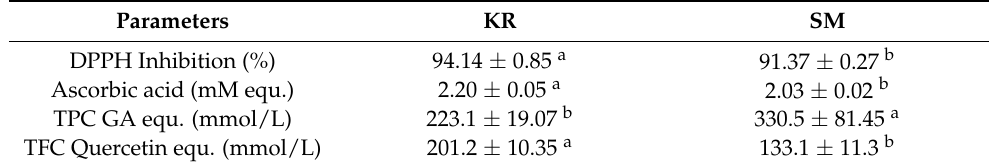
Table 5. Evaluation of antioxidant activity, total polyphenol, and total flavonoid contents of kudzu roots (KR) and soy molasses (SM)